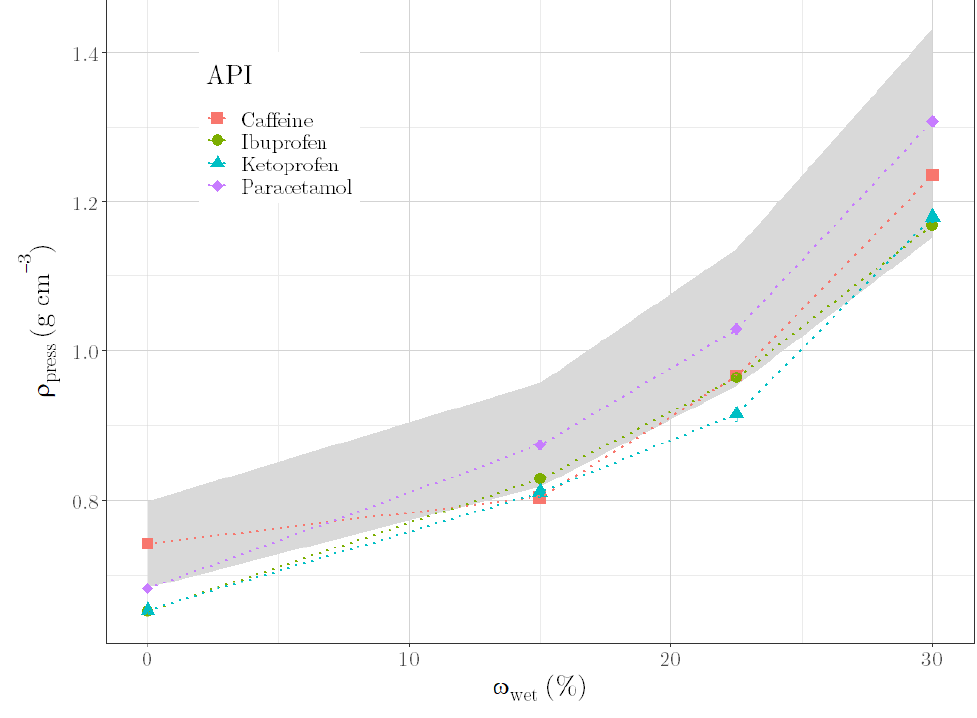
Figure 9. ρ press versus ω wet for ternary formulations with 40% API, 40% Lac 200 and 20% MCC 101. Highlighted in gray: range between the measured values of the binary formulation with Lac 200 and MCC 101 in a ratio of 60:40 (lower limit) and 80:20 (upper limit).